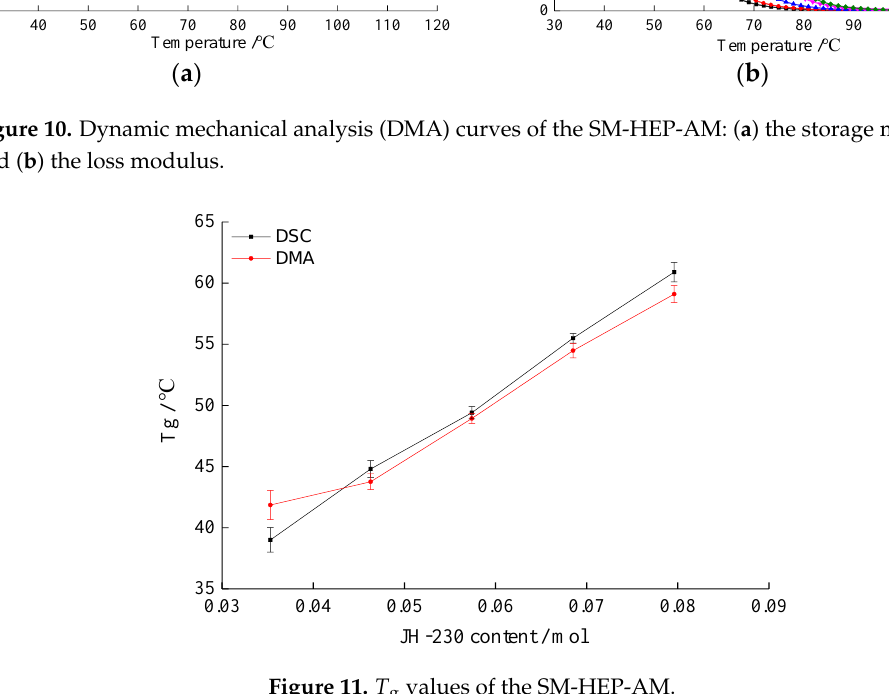
Figure 11. T g values of the SM-HEP-AM.